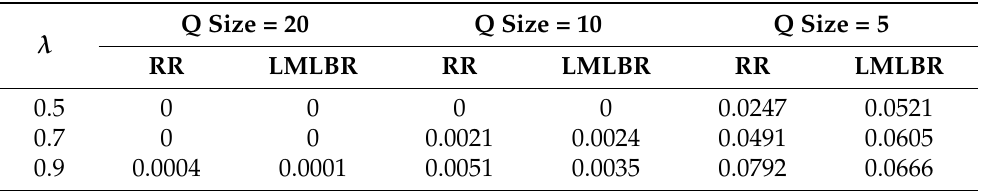
Table 4. Task blocking rate versus queue size.